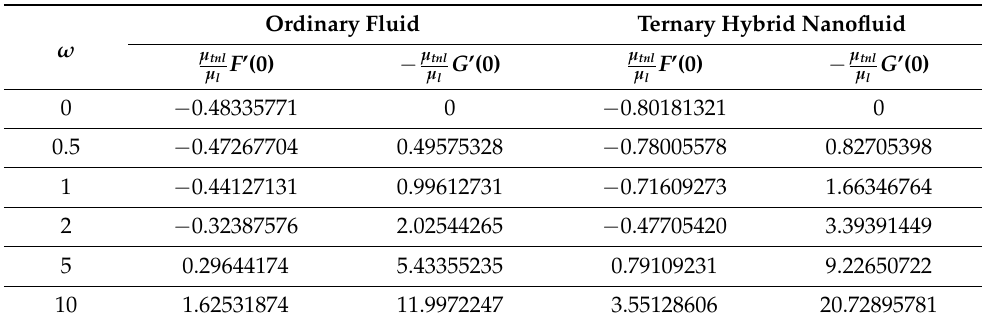
𝐹′(0) , and − (cid:3091) (cid:3295)(cid:3289)(cid:3287) 𝐺′(0) for different values of 𝐻𝑎 . Table 3. The values of (cid:3091) (cid:3295)(cid:3289)(cid:3287) F (cid:48) ( 0 ) , and − µ tnl G (cid:48) ( 0 ) for different values of Ha . Table 3. The values of µ tnl (cid:3091) (cid:3287) (cid:3091) (cid:3287) µ l µ l Ordinary Fluid Ternary Hybrid Nanofluid Ordinary Fluid Ternary Hybrid 𝝁 𝑯𝒂 𝒕𝒏𝒍 Ha 𝑭′(𝟎) 𝝁 𝒍